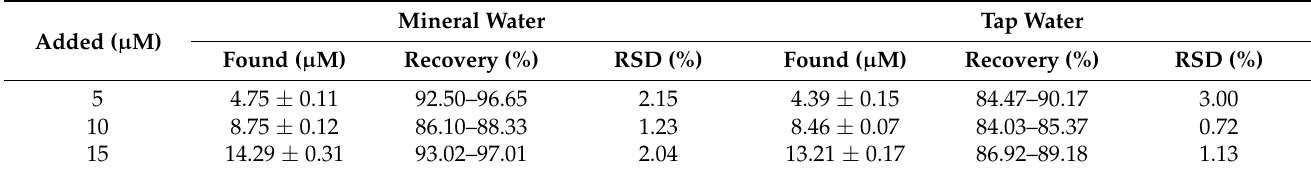
Table 2. Determination and recovery tests of Hg 2+ in real water samples (n = 3).